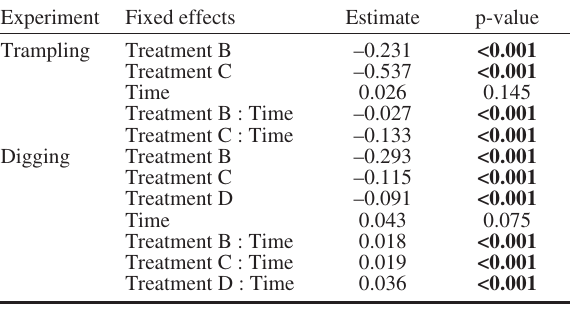
Table 3. – Generalized linear mixed model (GLMM) results indi- cating probability values for plant shoot density in both pressure experiments (trampling and digging). GLMM includes fixed effects (treatment and time), interaction between treatment and time, and random effects for plot replicates. In bold, significant p-values (<0.05) for fixed effects. Treatments: B, light pressure; C, heavy pressure; D, continuous pressure.